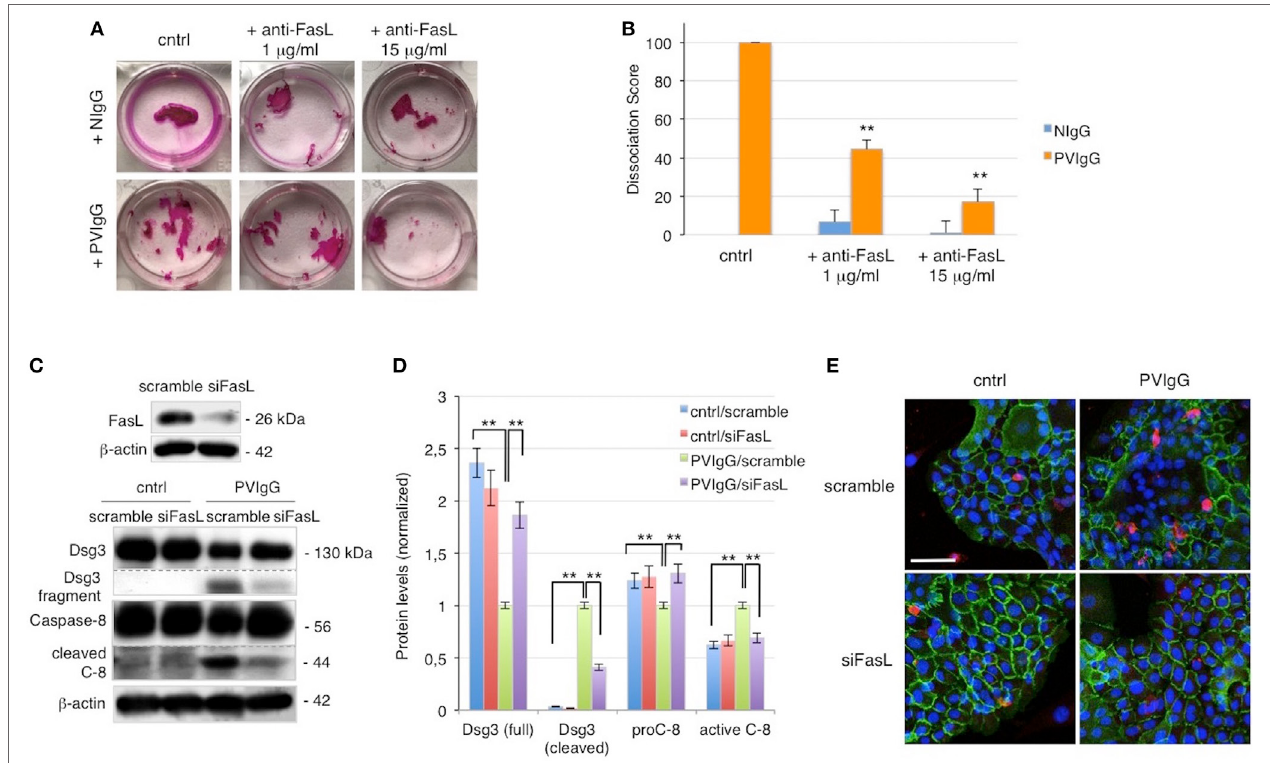
FigUre 2 | Keratinocyte-derived Fas ligand (FasL) induces desmoglein (Dsg)3, cleavage, and caspase activation. (a,B) Anti-FasL antibody (Ab) prevents keratinocyte acantholysis. Keratinocytes were cultured with purified normal human IgG (NIgG) or pemphigus autoantibodies (PVIgG) in the presence or absence of anti-FasL Ab (1 or 15 µg/ml), and dispase-based dissociation assay was performed. (a) Representative images of cell sheet fragmentation. (B) Quantification obtained by counting the number of fragments of cell sheets and represented as dissociation score (means ± SEM; ** P < 0.01 per one-way ANOVA versus PVIgG; n = 5 independent experiments). (c–e) FasL silenced keratinocytes are protected from PVIgG-induced acantholysis and apoptosis. FasL or scrambled siRNA transfected keratinocytes were treated with PVIgG or diluent (cntrl), and levels of Dsg3 and caspase-8 were assessed by immunoblot (c) and measured by relative protein quantification (D) . (e) Immunofluorescence showing Dsg3 (green) and active caspase-3 (red) expression in keratinocytes. Scale bar = 70